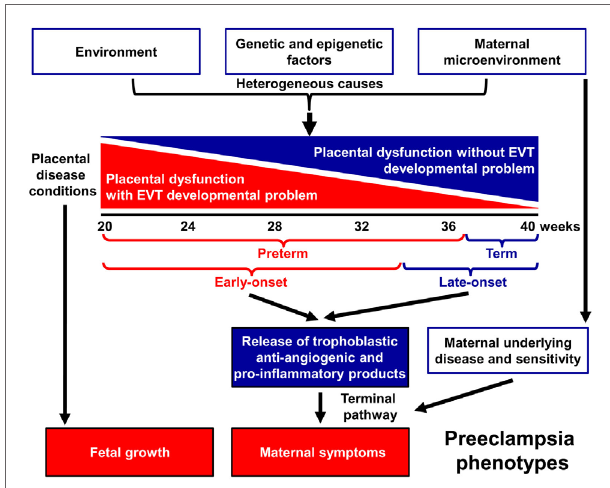
FigUre 1 | Pathogenesis of preeclampsia. Preeclampsia is a syndrome with heterogeneous etiology and a spectrum of phenotypes. It may appear at varying gestational ages with different degrees of severity and involvement of the fetus. Preterm, especially early-onset preeclampsia generally has a more severe clinical presentation in the mother and is more often associated with the delivery of a growth-restricted neonate than term or late-onset preeclampsia. It is a multi-stage disease with the maldevelopment and/or dysfunction of distinct trophoblast lineages of the placenta at the center of the disease. Villous and extravillous trophoblast (EVT) development and/or function may be impaired in the preclinical stage, most extensively in preterm preeclampsia associated with fetal growth restriction. The resulting abnormal maternal spiral artery remodeling, fluctuating blood-flow, and ischemic stress lead to placental histological changes and the release of harmful substances from the placenta. As a consequence, the terminal pathway of preeclampsia, an exaggerated maternal systemic inflammatory and anti-angiogenic condition, occurs. The frequency and severity of placental developmental problems continuously decrease with advancing gestational age. In term forms, other stressors than maternal vascular malperfusion and placental ischemia may trigger placental stress, trophoblastic dysfunction, and the induction of the terminal pathway. Alternatively, the maternal endothelium may have an exaggerated sensitivity to factors released from a relatively normal